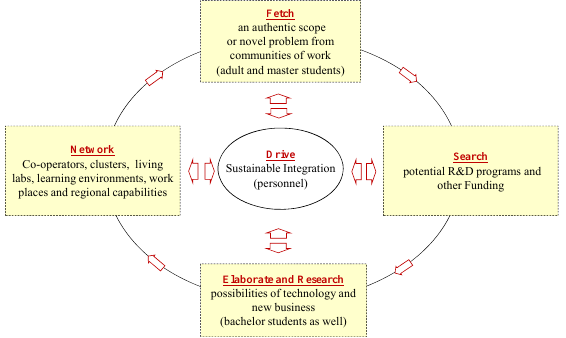
Figure 6. Empirical Model of Sustainable Driver to R&D integration in the SATERISK project